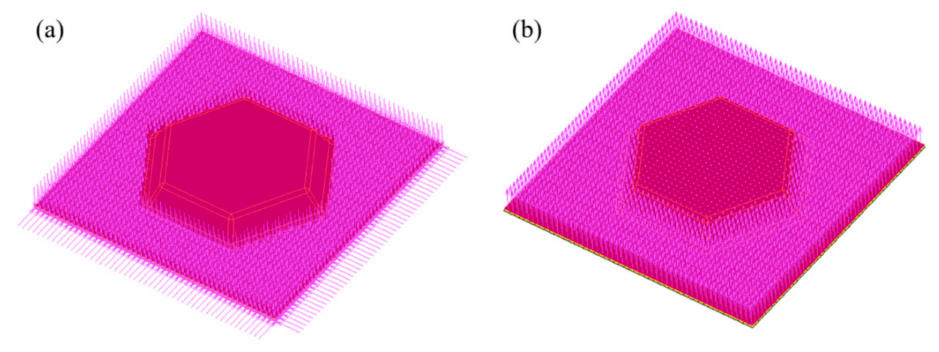
Figure 14. Boundary conditions of the finite element model ( a ) displacement boundary condition ( b ) face load boundary condition.